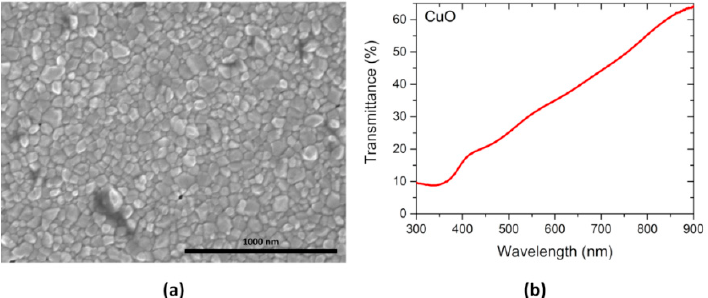
Figure 3. Top-view SEM micrograph of the CuO matrix annealed at 700 °C ( a ) and the respective optical transmittance spectrum ( b ).